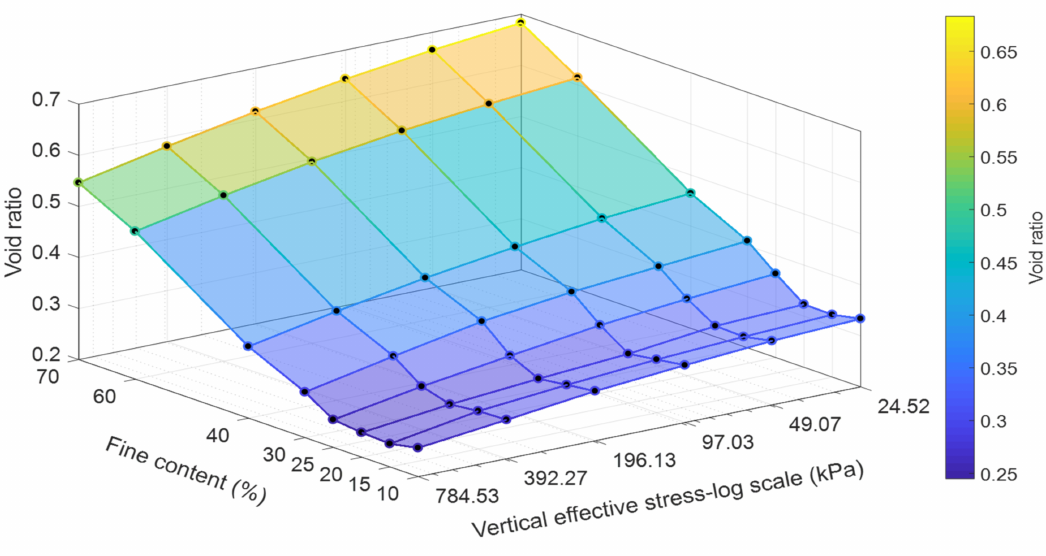
Figure 7. Variation of void ratio with fines content and vertical effective